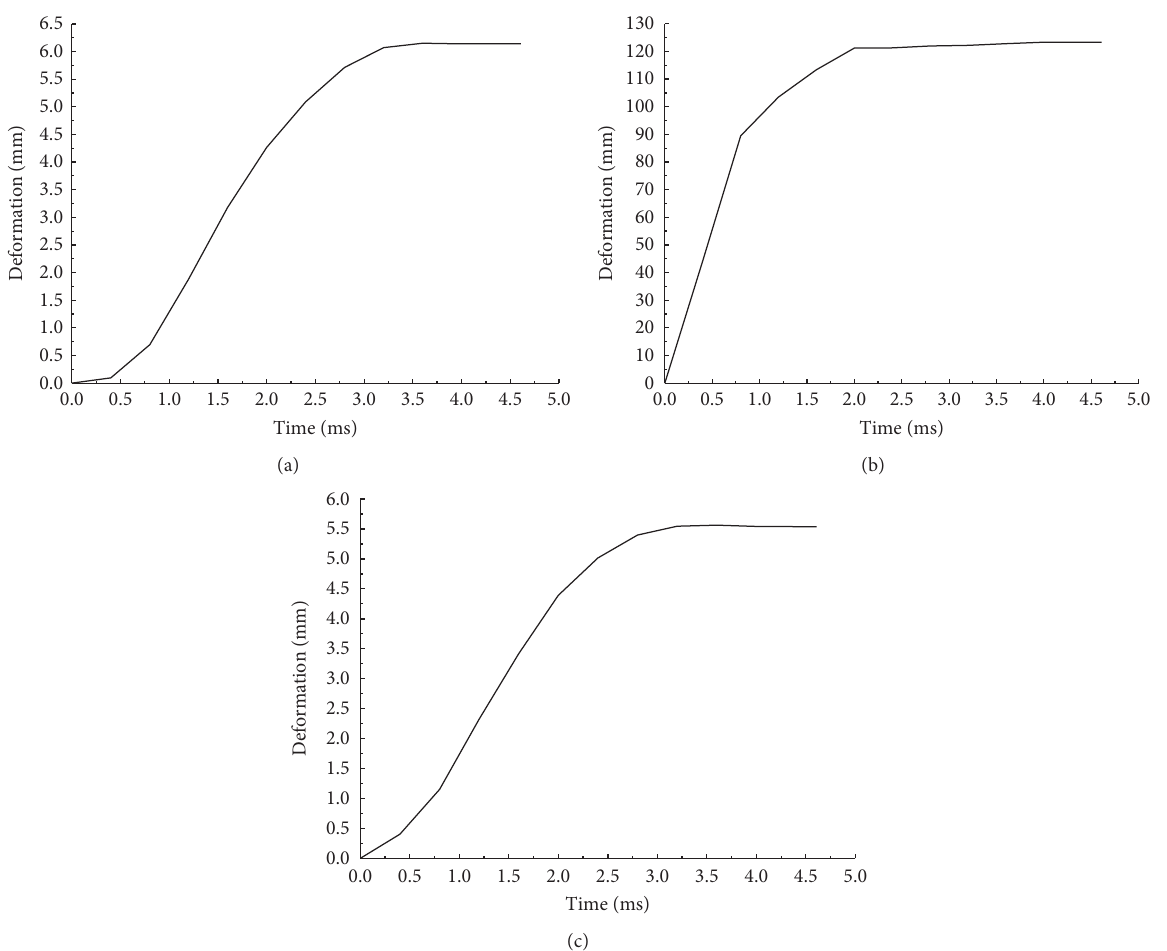
Table 12: Final deformation values at different positions on the column surface facing the explosive. Position Bottom − 7.53